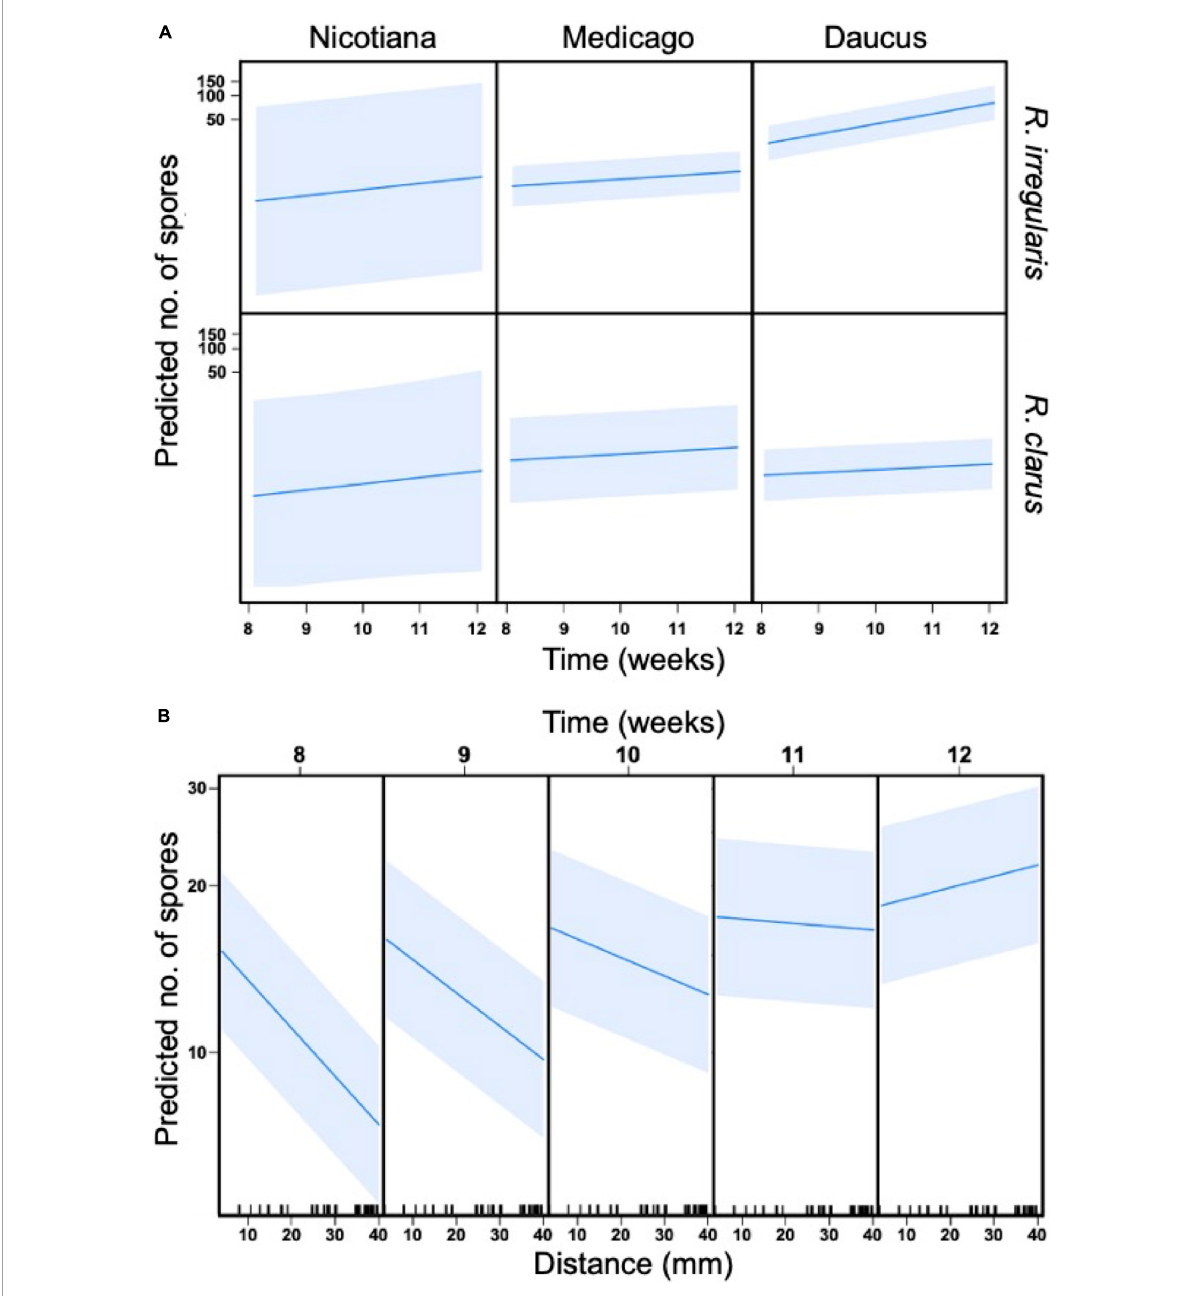
FIGURE3 General linear mixed models (GLMM) with four predictor variables, host (Nicotiana, Medicago, Daucus), AMF ( R. irregularis and R. clarus ), time (8, 10, and 12 wpi), and distance (mm, location of grid squares in relation to hyphal bridge), and their effect on spore production (dependent variable). Petri dish ID (individual replicates) were used as random effect. (A) Three-way interaction between time, AMF, and host. The slope of each individual graph indicates a relationship between predictors and spore production, while the shaded area illustrates standard error. (B) Two-way interaction between distance and